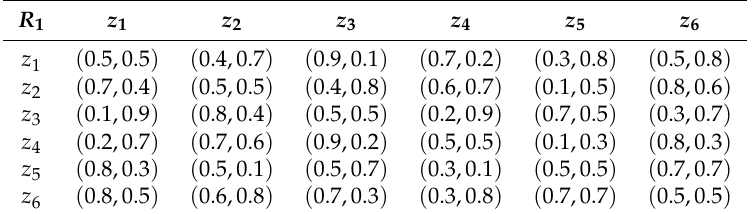
Figure 5.1: Pythagorean fuzzy digraphs. Figure 21. Pythagorean fuzzy digraphs.